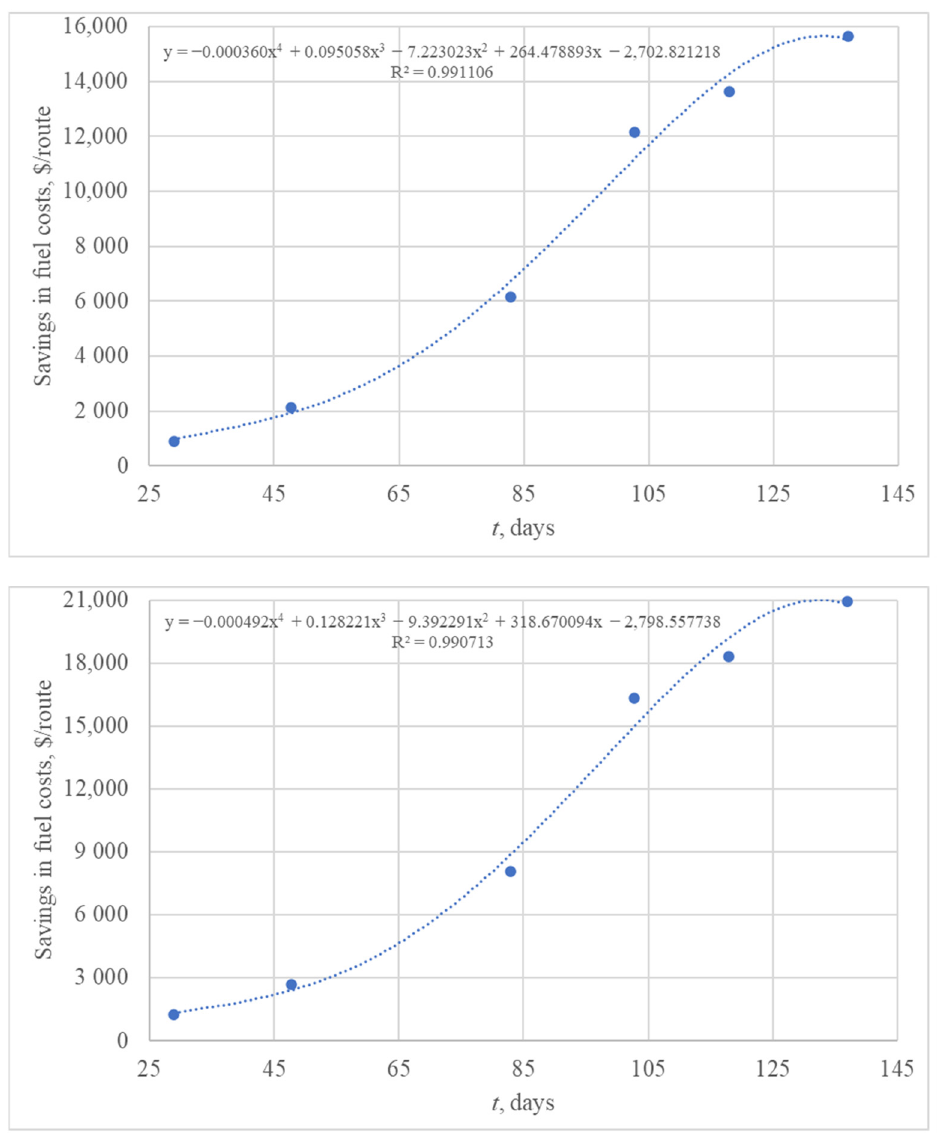
Figure 5. The obtained savings in fuel costs related to the underwater hull cleaning for PP (upper) and PPP (lower) containership classes